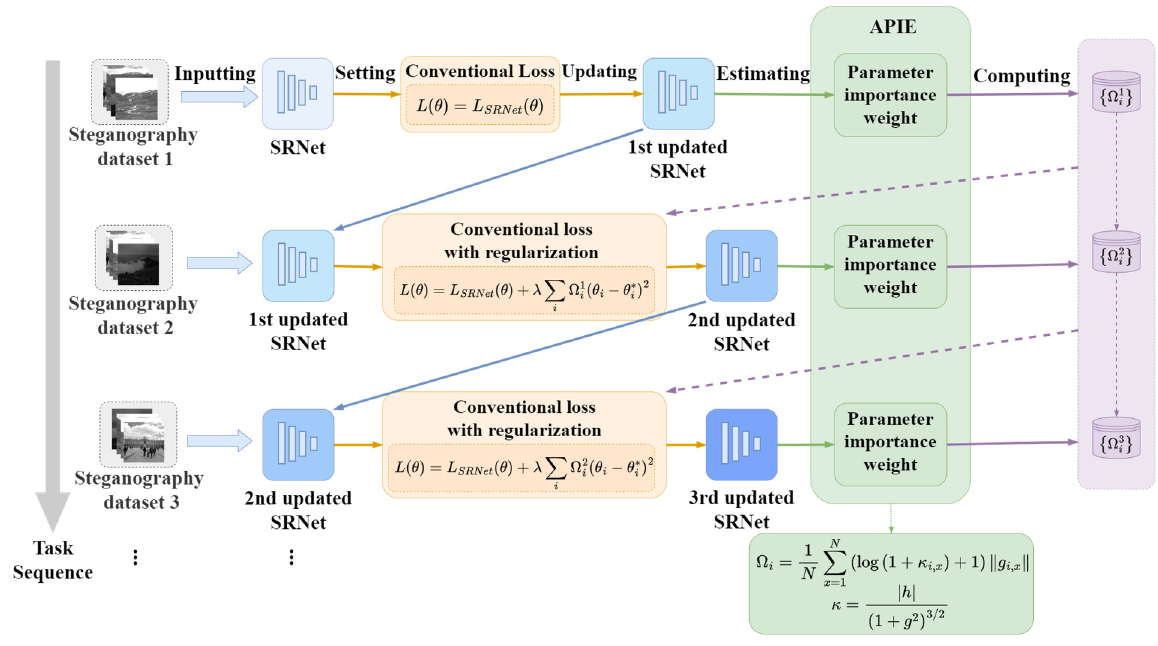
Figure 1. Overview of our continual learning scheme for steganalysis. During each steganalysis task iteration, the steganalysis model estimates the importance weight for each network parameter and stores it. After each steganalysis task on the corresponding dataset, the model calculates the regularization term by using the stored importance weights and combines it with task-specific backward loss. The network parameters of this model are updated under the restriction of the regularization term to obtain favorable performance on a new task while maintaining satisfactory performance on previous tasks.